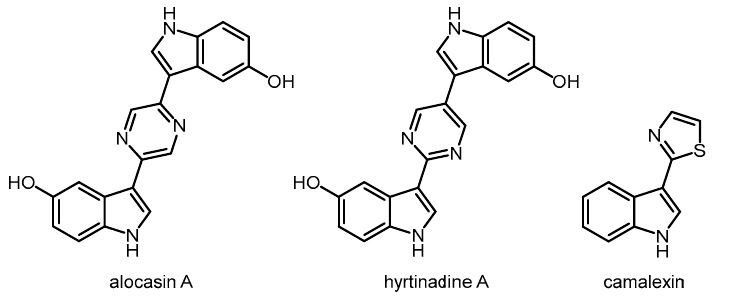
Figure 2. Natural products alocasin A, hyrtinadine A and camalexin synthesized via MBSC se- quence.